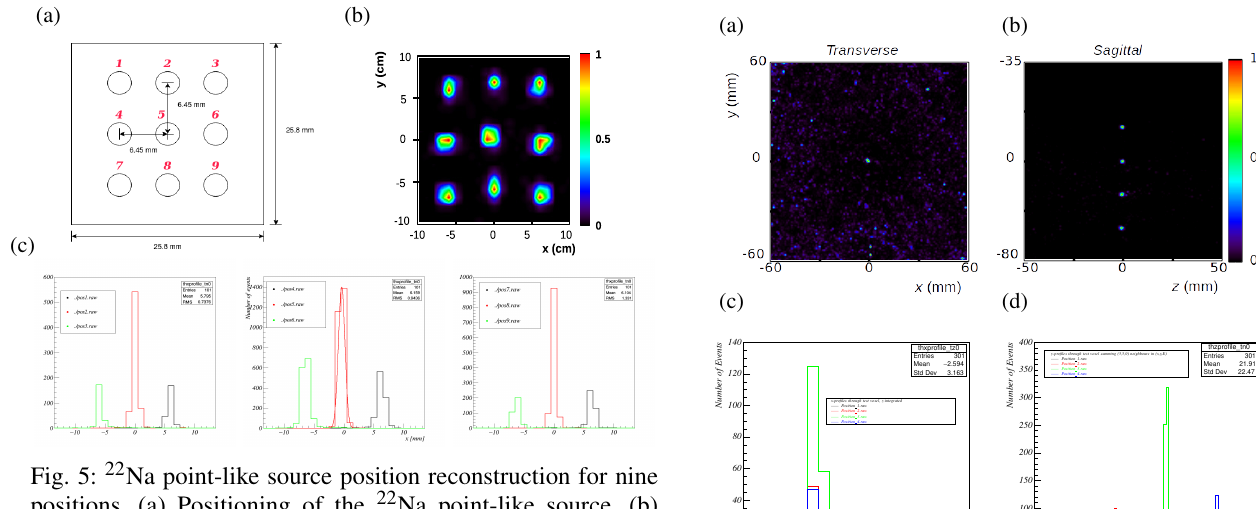
Fig. 5: 22 Na point-like source position reconstruction for nine positions. (a) Positioning of the 22 Na point-like source. (b) Reconstructed data. (c) Profiles of the reconstructed data.